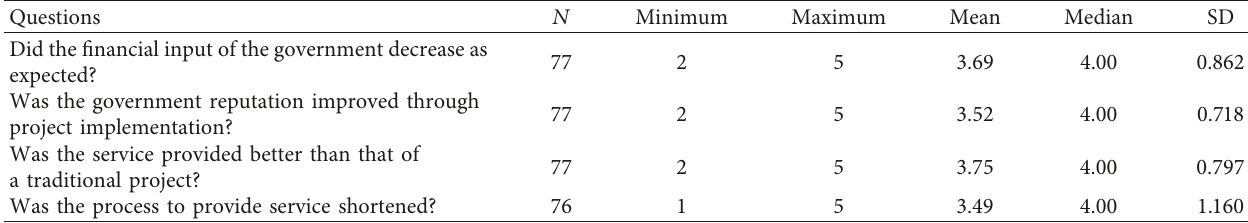
Table 6: Descriptive data of the project success dimension “benefits to public